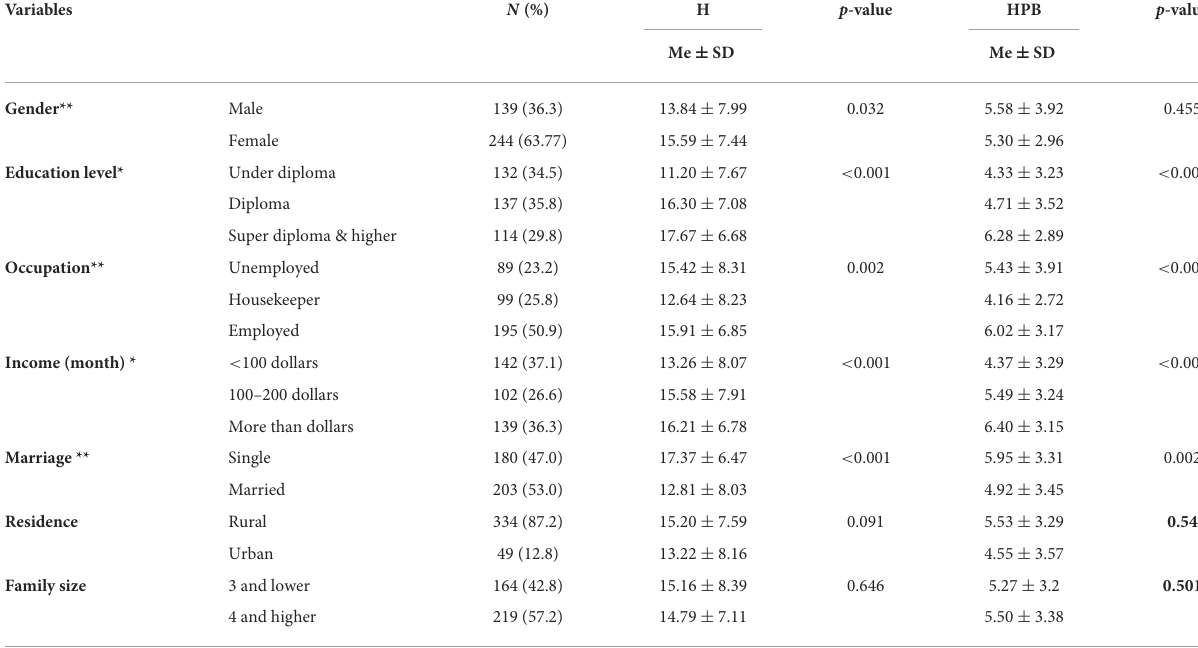
TABLE 1 Relationship between eHL, HPBs, and some of demographic characteristics among people. Variables